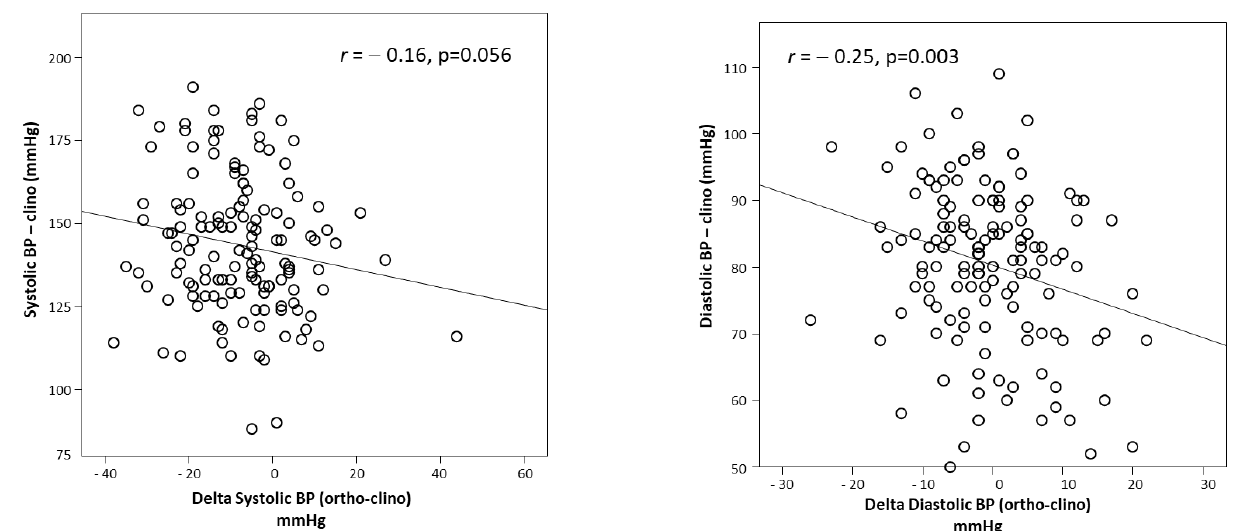
Figure 2. Correlation between changes in systolic ( left panel ) and diastolic ( right panel ) blood pressure (BP) from supine to upright positions and the corresponding supine BP component.